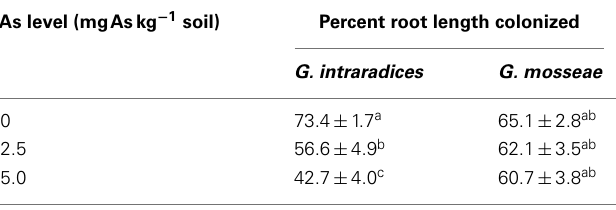
Table 3 | Percent root length colonized in medic ( Medicago truncatula ) grown in pots with two levels of phosphorus (P; 10 and 20mgPkg − 1 soil) with no addition of arsenate (0) orAsV added at the rates of 2.5 and 5mgAskg − 1